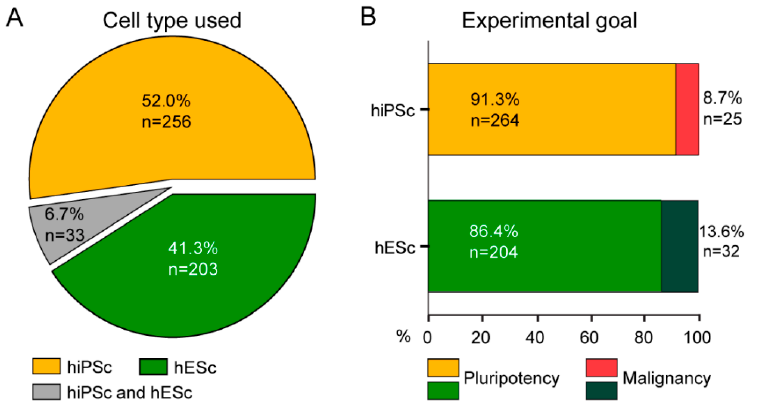
Figure 2. Cell types used and the primary goal of the teratoma assay. ( A ) Number of hiPSC and/or hESC cell lines used in the teratoma assay between (2000–2020). ( B ) The teratoma assay is mostly used for assessing pluripotency, and in a limited number of cases, for assessing malignancy.